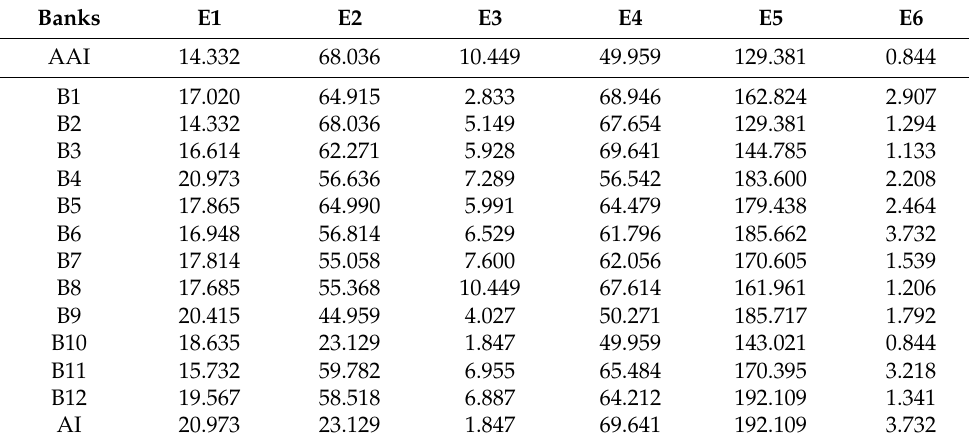
Table 12. The extended initial matrix of bank efficiency for pre-COVID-19.